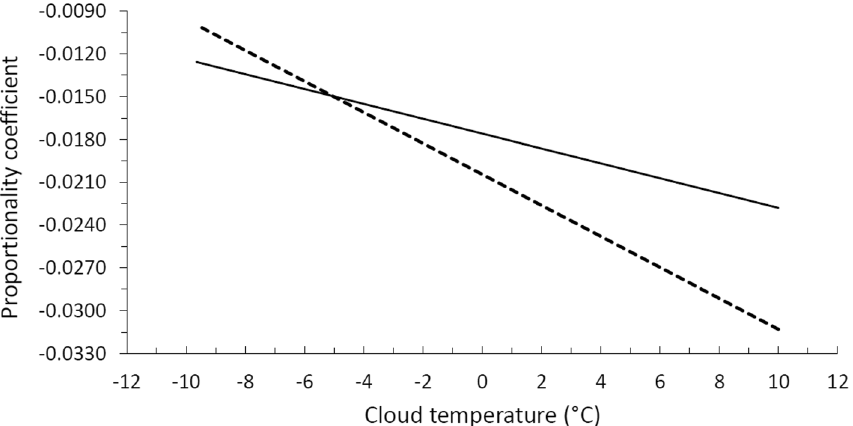
Figure 1. Proportionality coefficient computed from (4) as a function of the cloud temperature for two values of the tropospheric lapse rate 6.5Kkm −